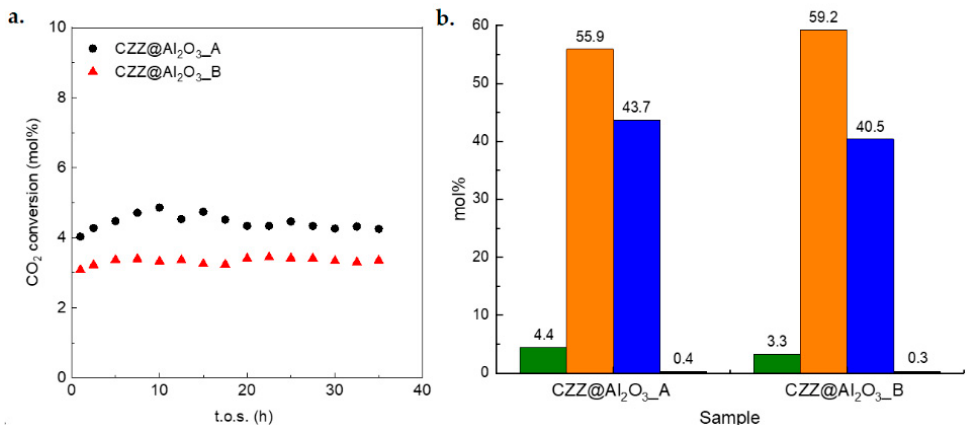
Figure 8. CO 2 conversion as a function of time-on-stream (t.o.s.) for the synthesized composite cat-